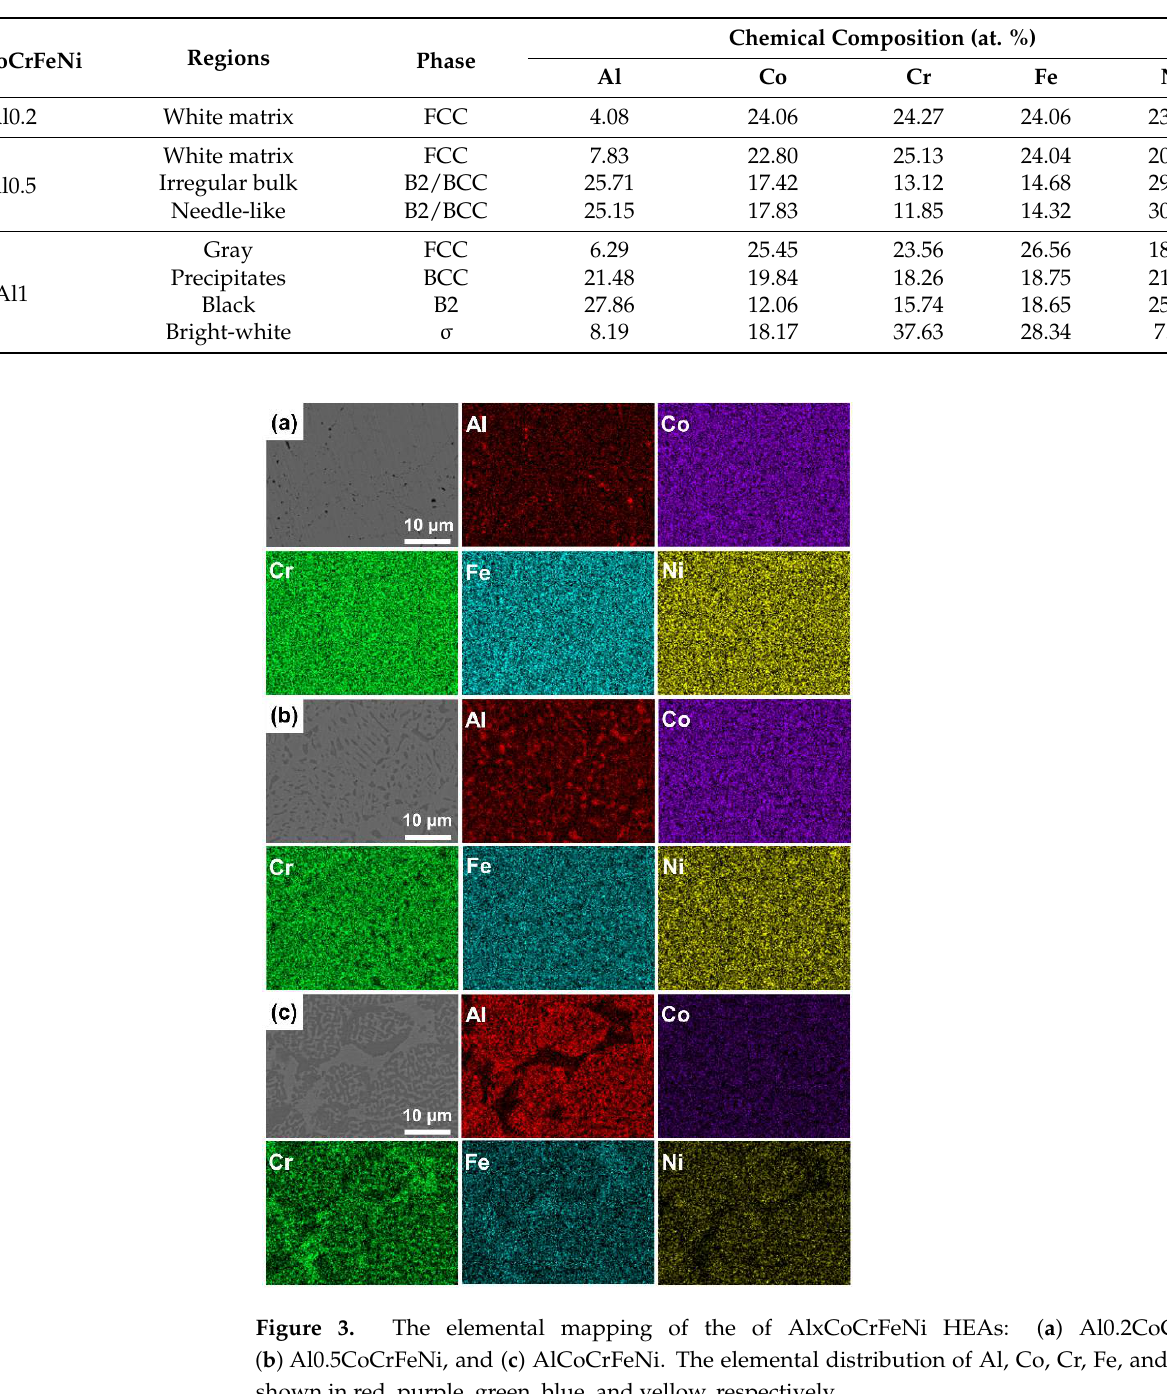
Table 1. EDS analysis results of AlxCoCrFeNi HEA (unit: at %), see Figure 2 for the specific phases.